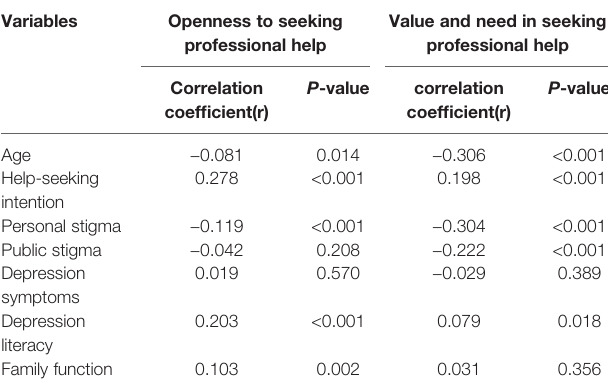
TABLE 4 | Correlation between age, help-seeking intention, stigma, depressive symptoms, depression literacy, family function, and ATSPPH.